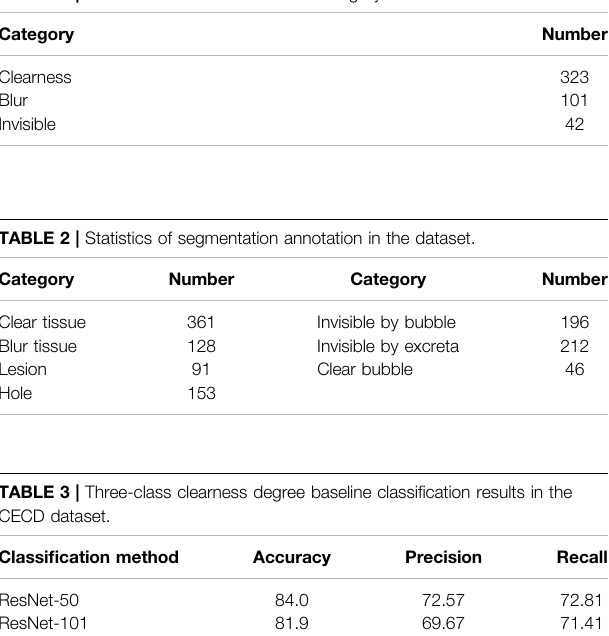
TABLE 1 | Details about the classi fi cation category distribution.